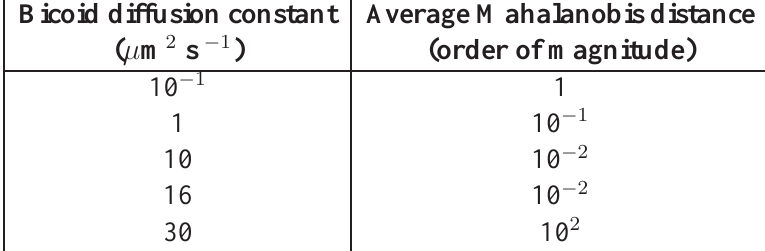
Table 2: Order of magnitude of the discrepancy between experiments of simulations performed wi th five nominal constant values of bicoid diffusivity. The best agreement has been achieved for a diffusivity around 10 µ m 2 s − 1 .